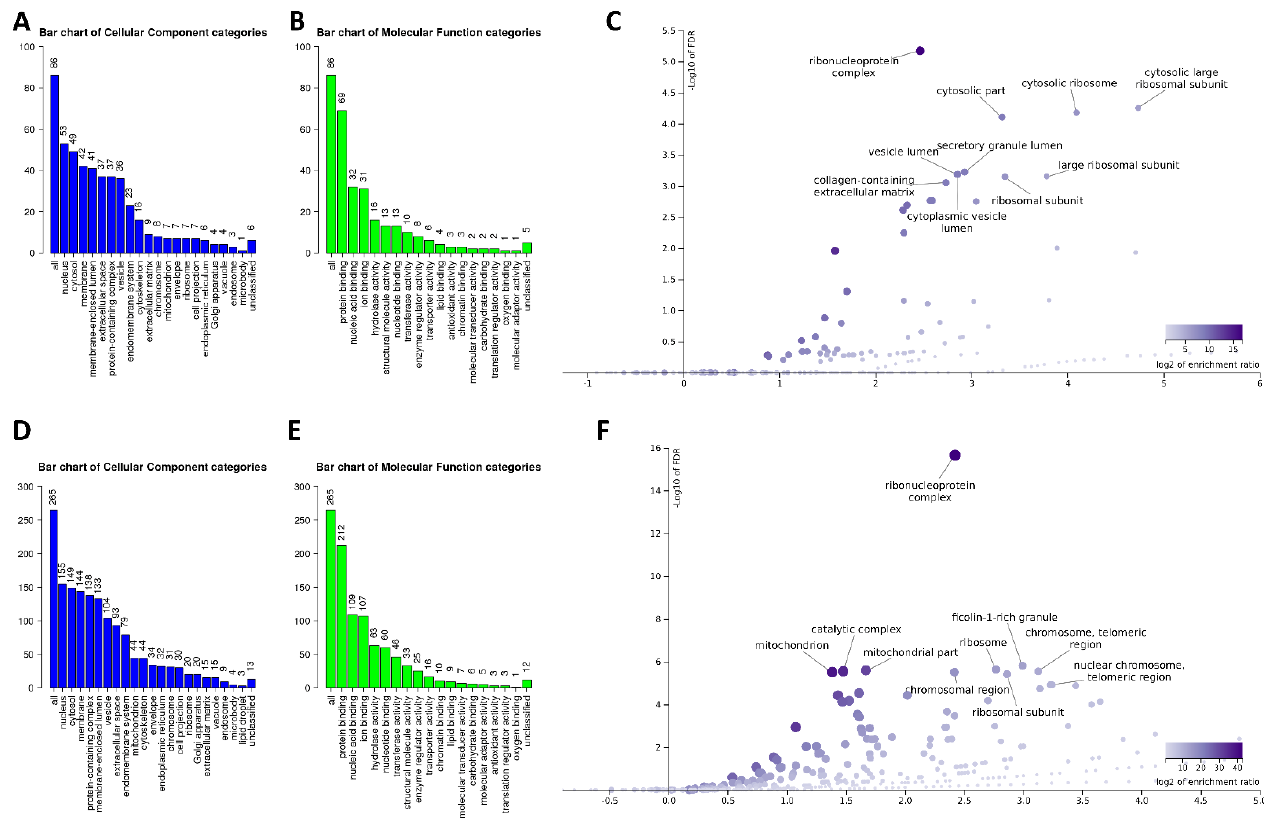
Figure 2. Gene Ontology ‘ Cellular Component ’ and ‘ Molecular Function ’ classification of TIA1 interacting proteins. ‘ Cellular Component ’ (blue bars) and ‘ Molecular Function ’ (green bars) categories of all TIA1 interacting partners in unstressed ( A , B ) and sodium arsenite-treated SK-N-SH cells ( D , E ). The height of the bar represents the number of protein IDs in the category. ( C,F ) ‘ Cellular Component ’ categories that are specifically enriched in unstressed and sodium arsenite-treated SK-N-SH cells, respectively. Both bar charts and Volcano plots were visualized using the WebGestalt analysis software.